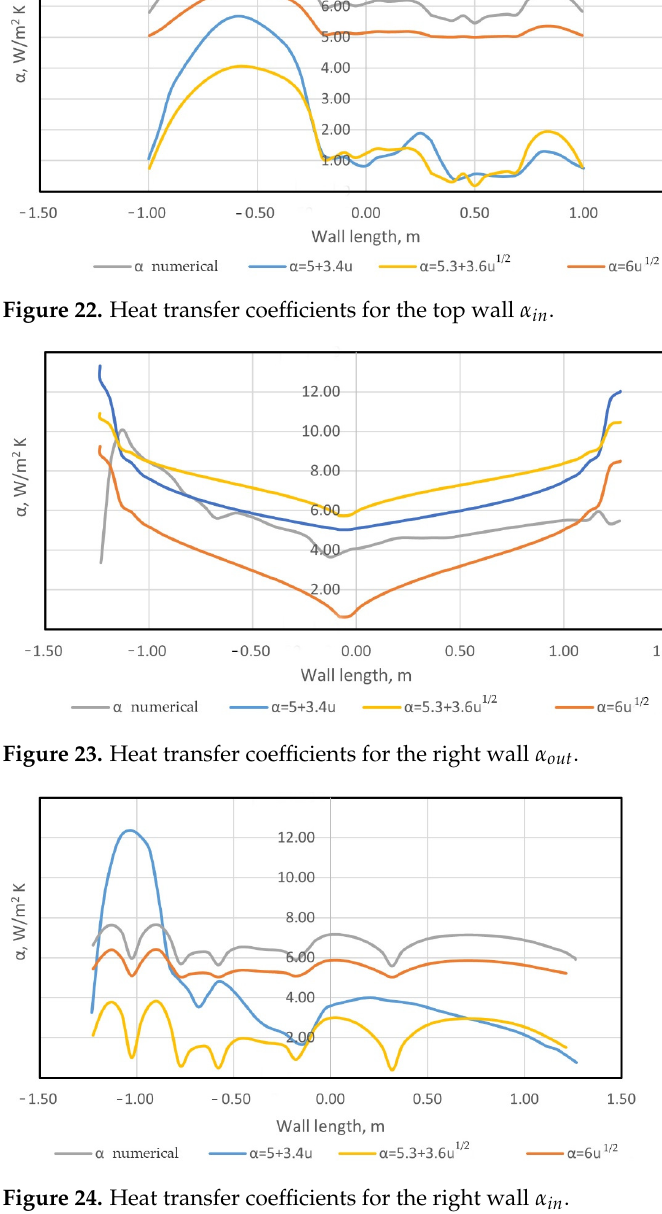
Figure 21. Heat transfer coefficients for the top wall α out .